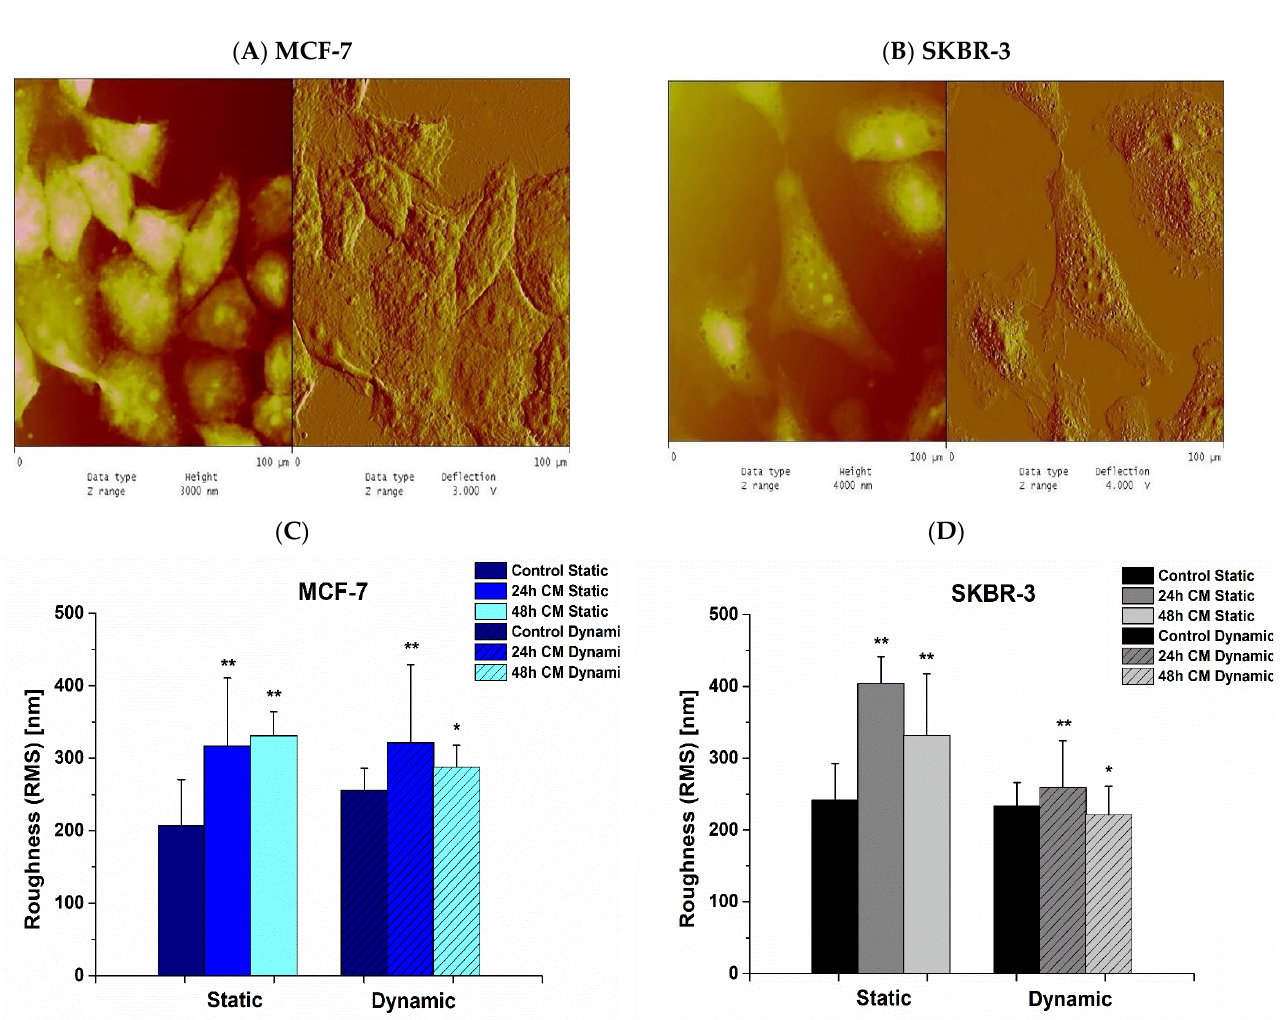
Figure 7. Representative AFM images of MCF-7 ( A ) and SKBR-3 ( B ) cancer cells 48 h post treatment after dynamic conditions. Quantitative AFM analysis displaying roughness of MCF-7 ( C ) and SKBR-3 ( D ) cancer cells’ membrane during 24 h and 48 h of treatment with hUMSCs-CM in both static and dynamic conditions. Data represent mean values ± SD of three independent experiments, * p < 0.05 and ** p < 0.01.